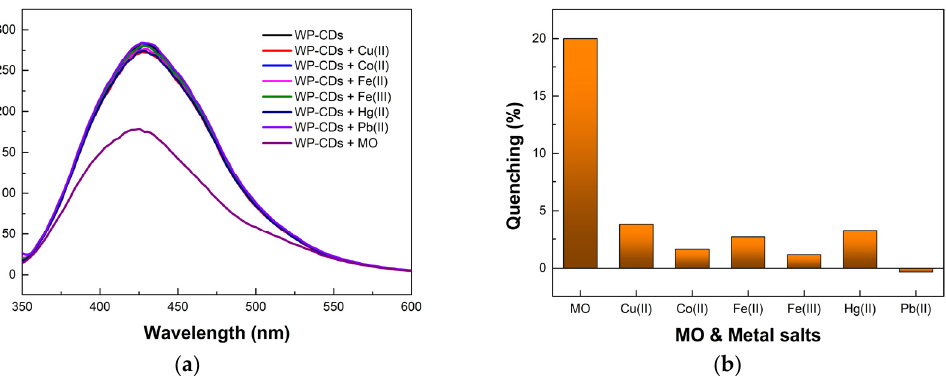
Figure 4. ( a ) Emission spectra of WP-CDs in phosphate buffer (pH = 7.2) in the absence and upon addition of the metal salts (10 μ M). Excitation at 340 nm. ( b ) Extent of quenching of WP-CDs fluorescence emission after contact with metal salts and MO. Data from MO corrected for IFEs; no correction was applied for the metal salts (optical densities at excitation and emission below 0.05). Competitive experiments with the highest effective quencher (MO) in the presence of other dyes, metal cations (perchlorate salts), and anions (sodium salts) were next carried